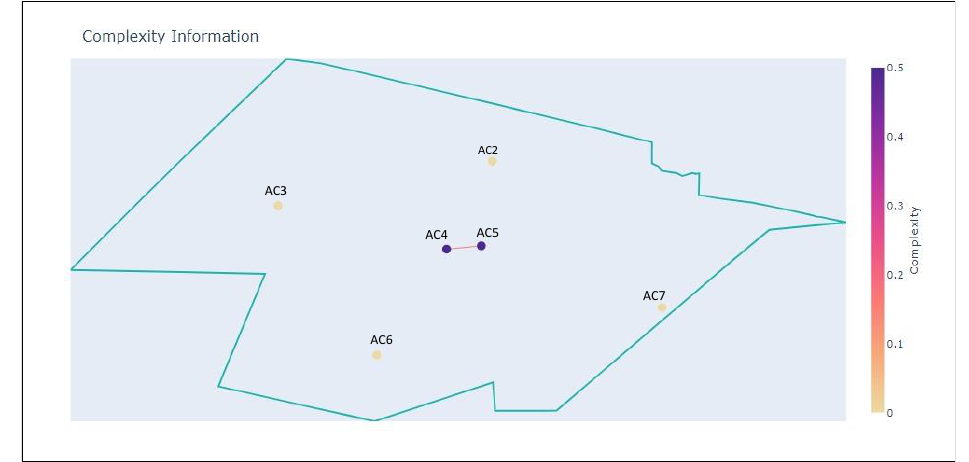
Figure 14. Sector at t 1 without AC1.